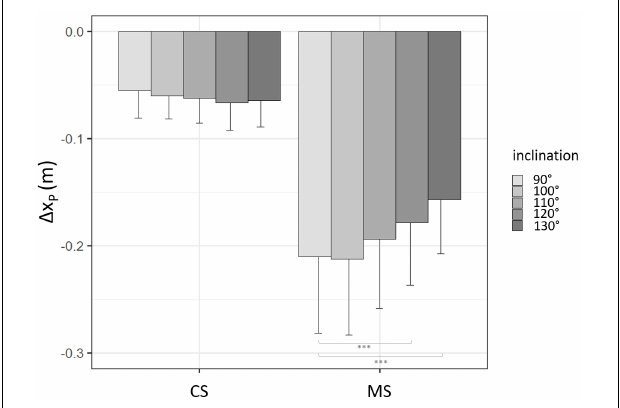
FIGURE 6 | Maximal CoP backward displacement as a function of speed and backrest inclination. Mean and standard deviations are presented for the 2 speed conditions and the 5 backrest inclination levels. ∗∗∗ p <